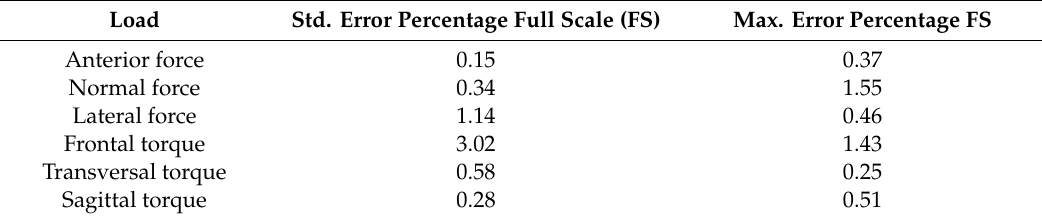
Table 2 addresses the calculated accuracy of the calibration matrix. Table 2. Seat post loading during cycling.